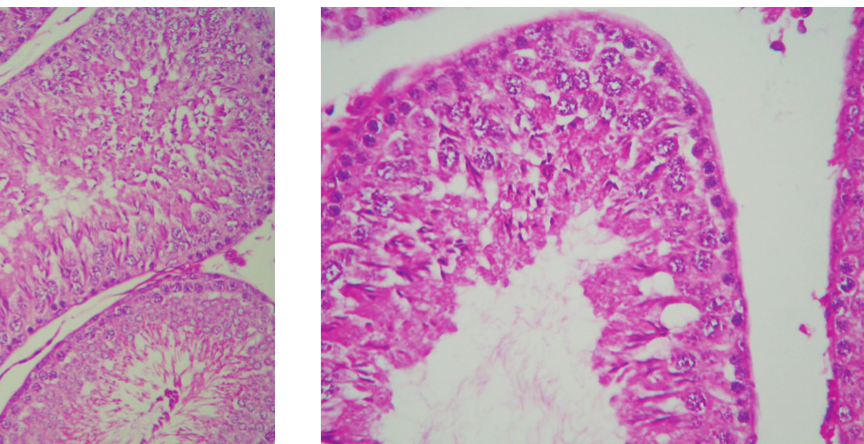
Figure1b - Complete spermatogenesis. Spermatogonia, spermatocytes, spermatids and many spermatozoa are seen from the basement membrane toward the lumen of the seminiferous tubule (H-E,